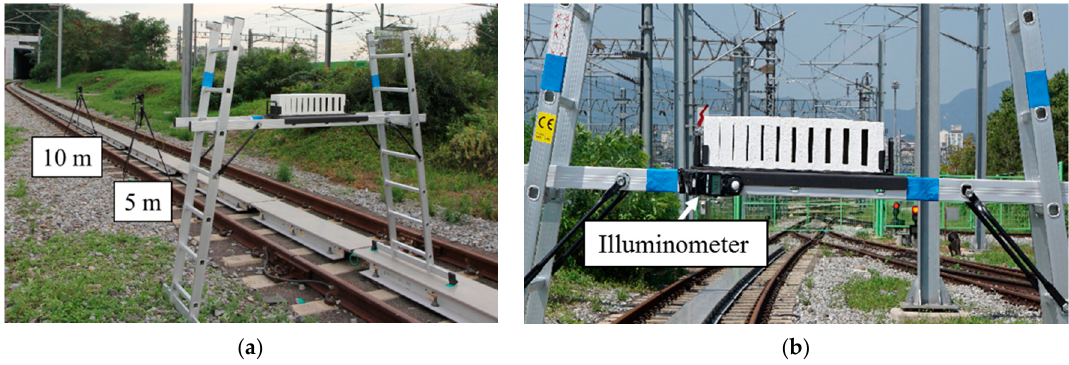
Figure 7. Image acquisition apparatus configuration: ( a ) Camera settings; ( b ) Illuminometer installation.